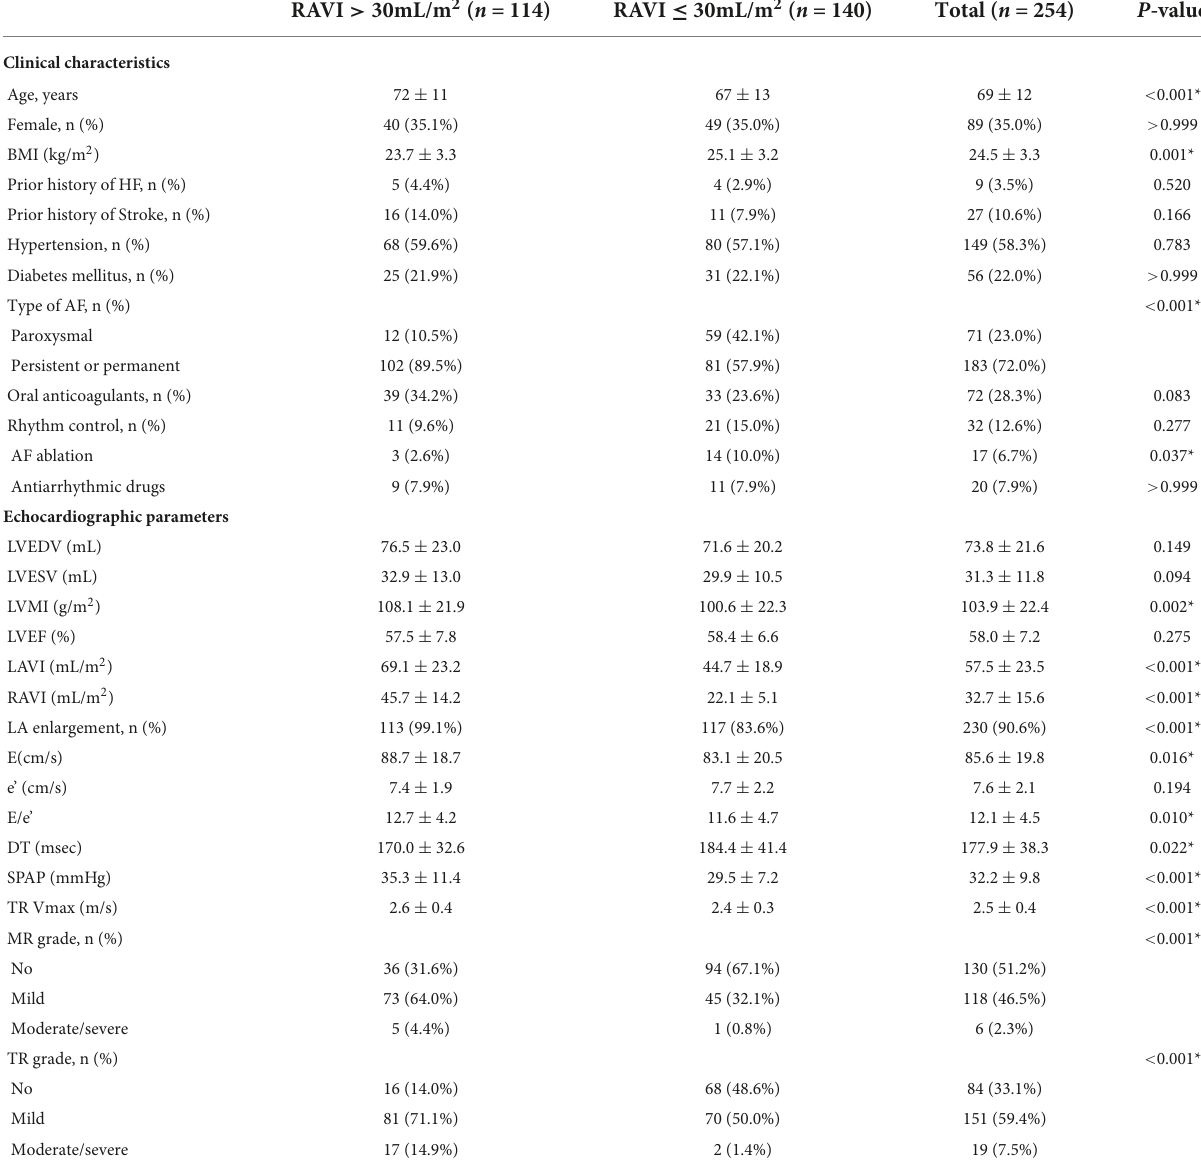
TABLE 1 Baseline characteristics of the study population according to the right atrial (RA)